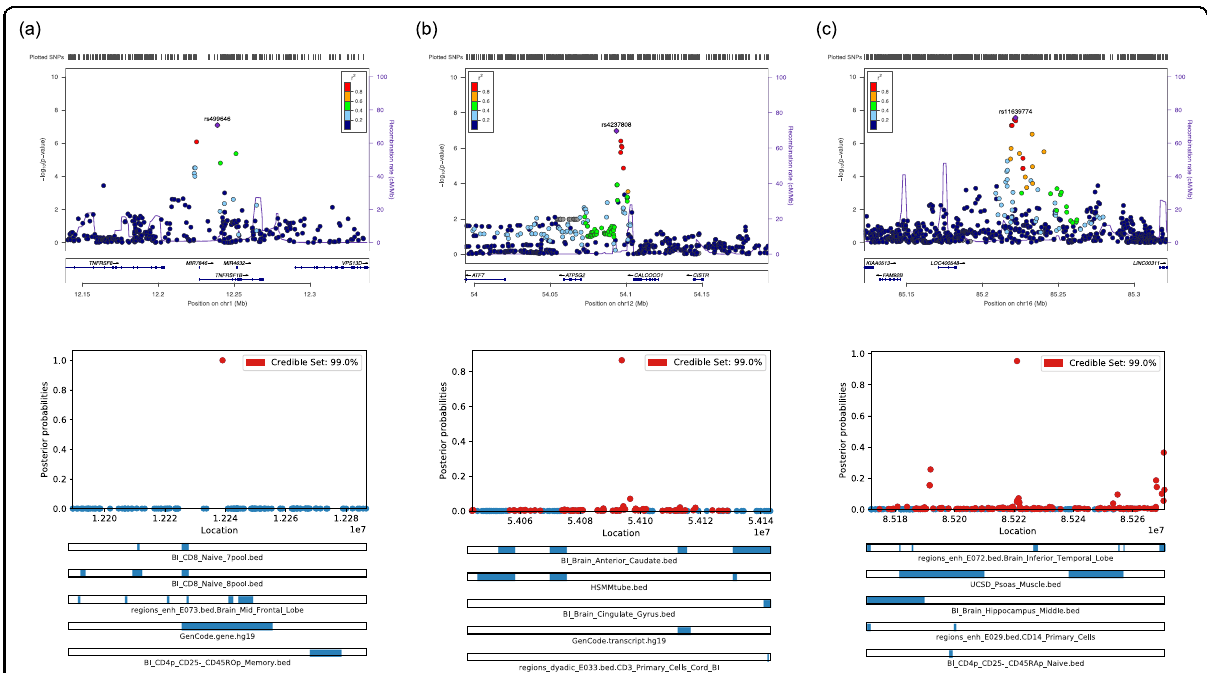
Fig. 3 Regional loci and fi ne-mapping plots. Top panel represents regional plots for a Chromosome 1, b Chromosome 12, and c Chromosome 16. Bottom panel represents the visualization of 99% credible SNP set for a Chromosome 1, b Chromosome 12, and c Chromosome 16, against location of SNP, with top annotation